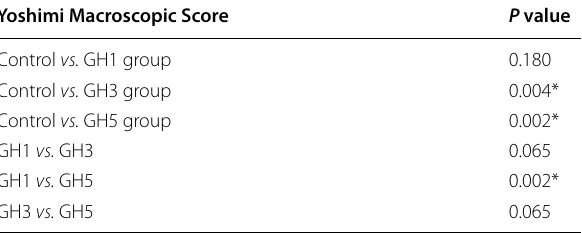
Table 3 Statistical analysis and comparison of Yoshimi score between groups